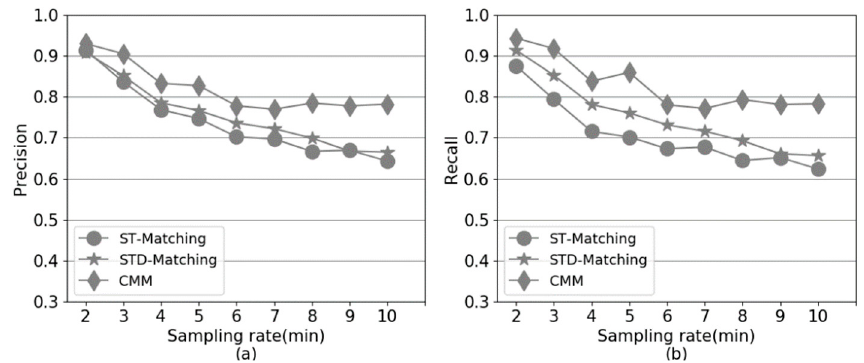
Figure 13. The performance comparison versus different sampling rates. ( a ) Precision. ( b ) Recall.